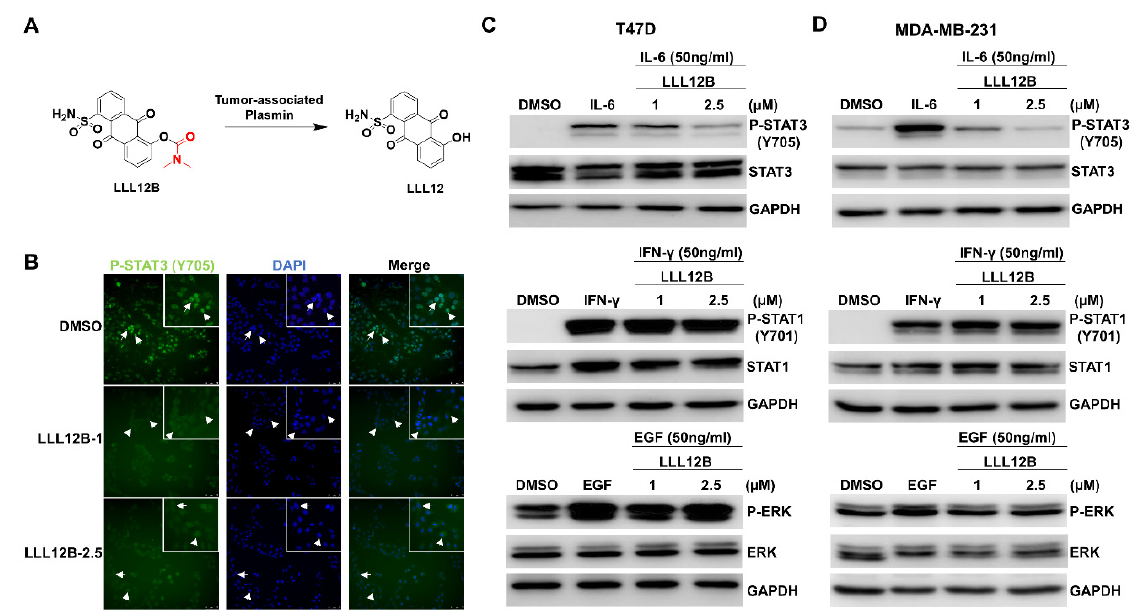
Figure 2. LLL12B inhibited STAT3 nuclear translocation and IL-6-induced STAT3 phosphorylation. ( A ) The chemical structures of LLL12B and LLL12. The carbamate ester bond of LLL12B is hydrolyt- ically cleaved by the tumor-associated plasmin to release LLL12. ( B ) SUM159 cells were seeded in a 6-well plate and treated with LLL12B for 8 h. Cells were stained with Phospho-Stat3 (Tyr705) and DAPI (indicated by arrows). Green: P-STAT3 (Y705); Blue: DAPI. T47D ( C ) and MDA-MB-231 ( D ) breast cancer cells were pretreated with DMSO or LLL12B in a serum-free medium for 2 h and stimulated with 50 ng/mL of IL-6, IFN- γ , or EGF for additional 30 min. Cells were collected and analyzed by Western blot analysis. GAPDH served as a protein loading control.